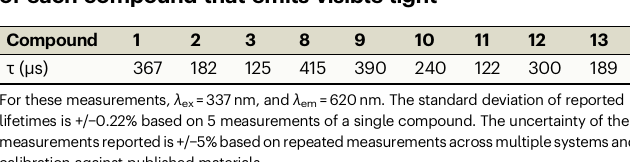
compounds with colors corresponding to the lifetime of each. These show the relative effectsofGdand Yb contentonemissionlifetimesof Euinthesematerials.